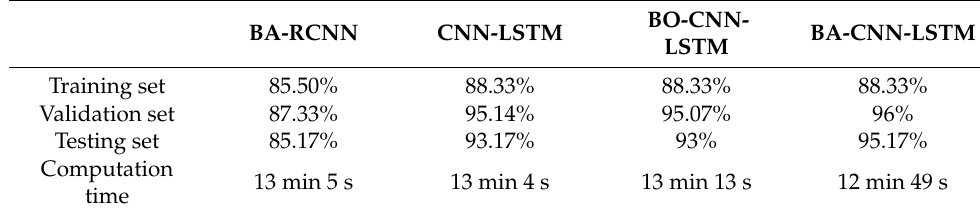
Table 6. The prediction accuracy and time for percent of porosity (artificial porosity